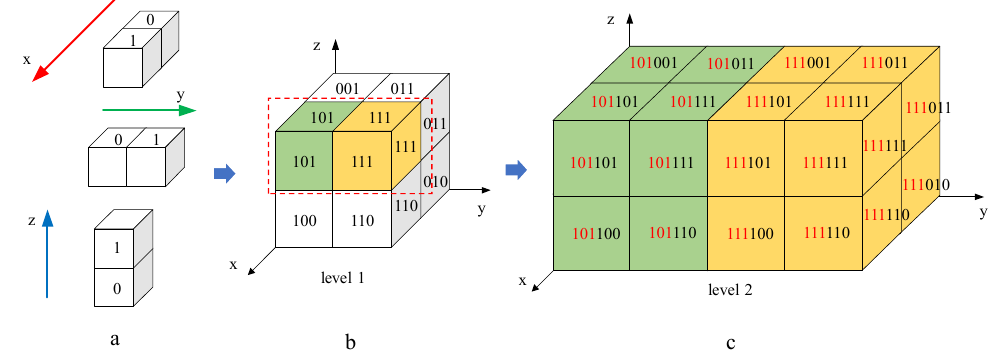
Figure 2. A highly efficient binary encoding octree data structure. ( a ) A voxel coded according to the X , Y , and Z axes with 0 or 1, ( b ) binary coding of octree in level 1, and ( c ) binary coding of octree in level 2 which is part of ( b ).